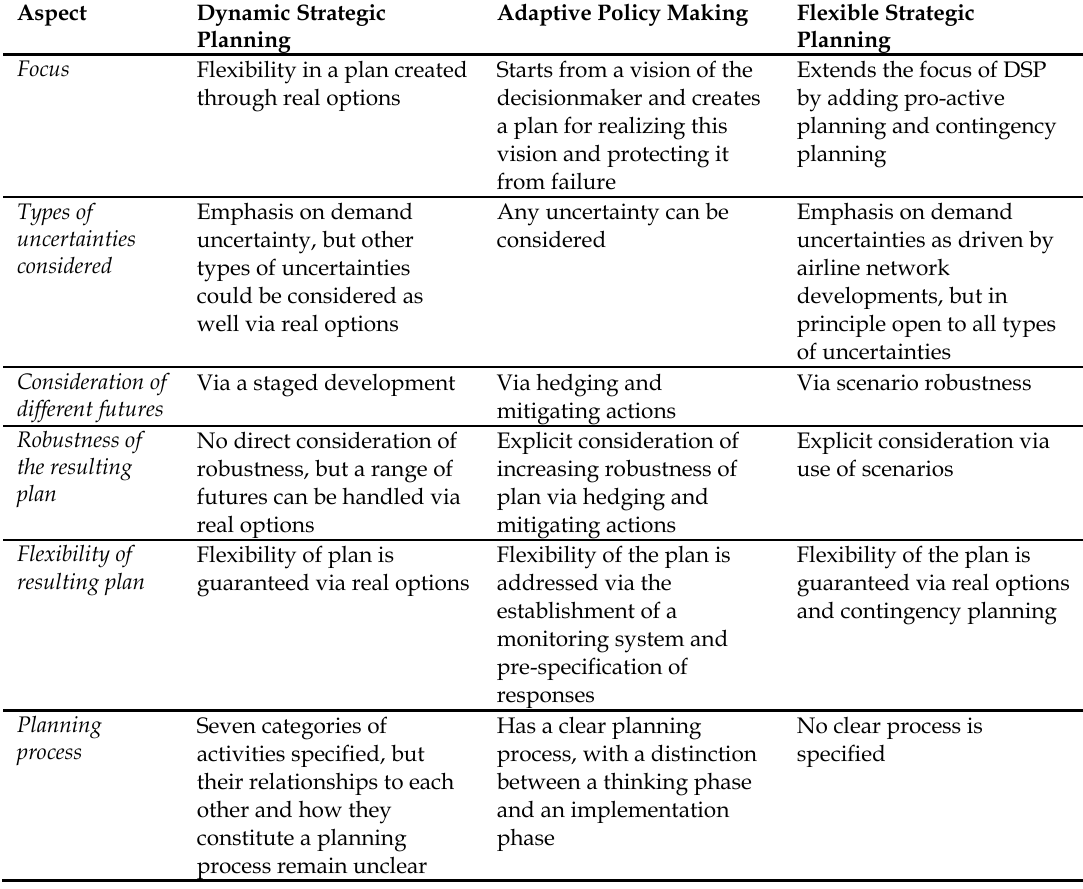
Table 1. Comparison of Three Approaches for Adaptive